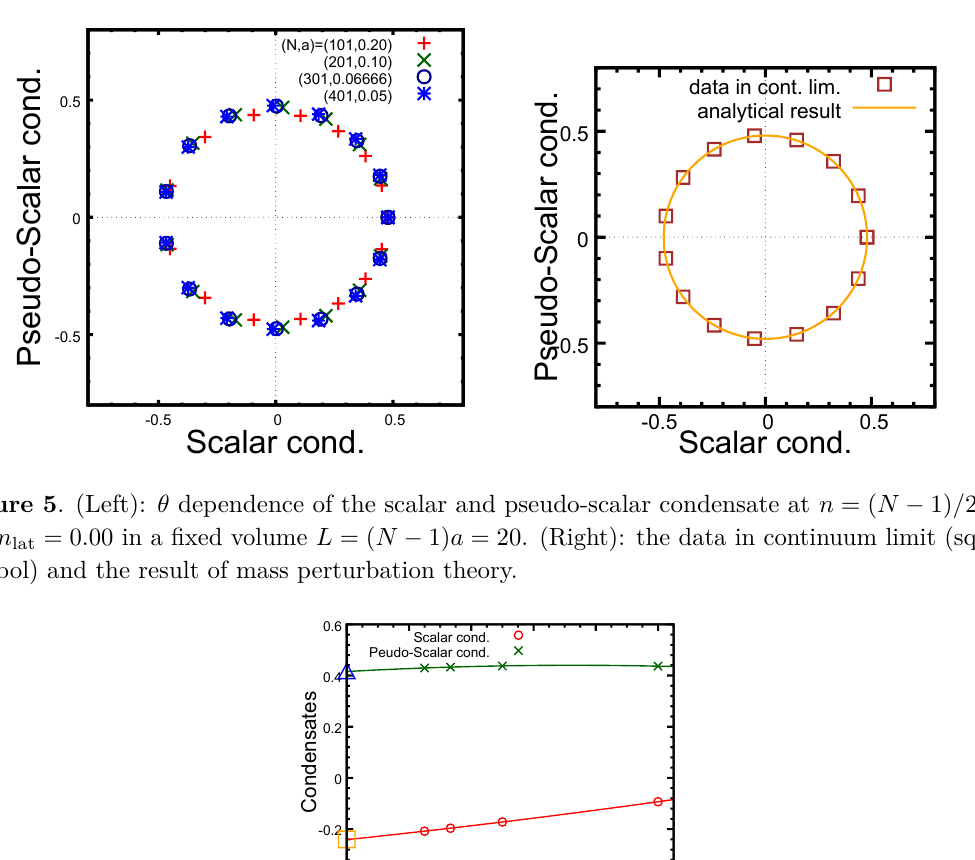
cos 2 π ' − 0 . 240 and P = e γ qg sin 2 π ' 0 . 415 , q q 2 π 3 / 2 2 π 3 / 2